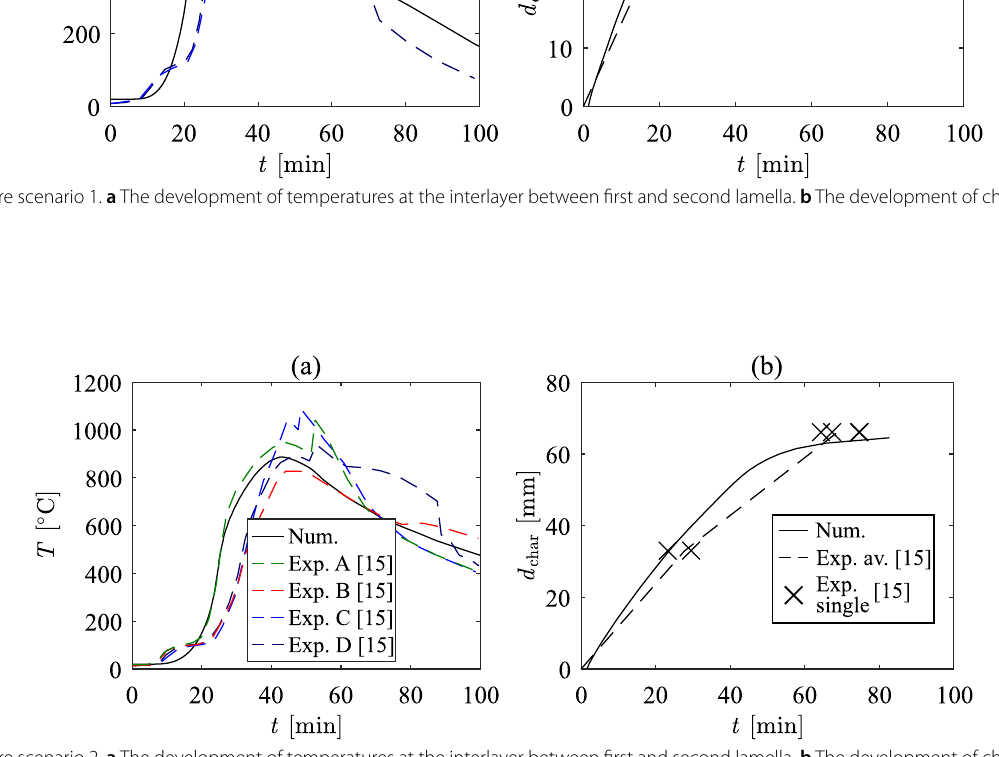
Fig. 12 Fire scenario 2. a The development of temperatures at the interlayer between first and second lamella. b The development of charring depth